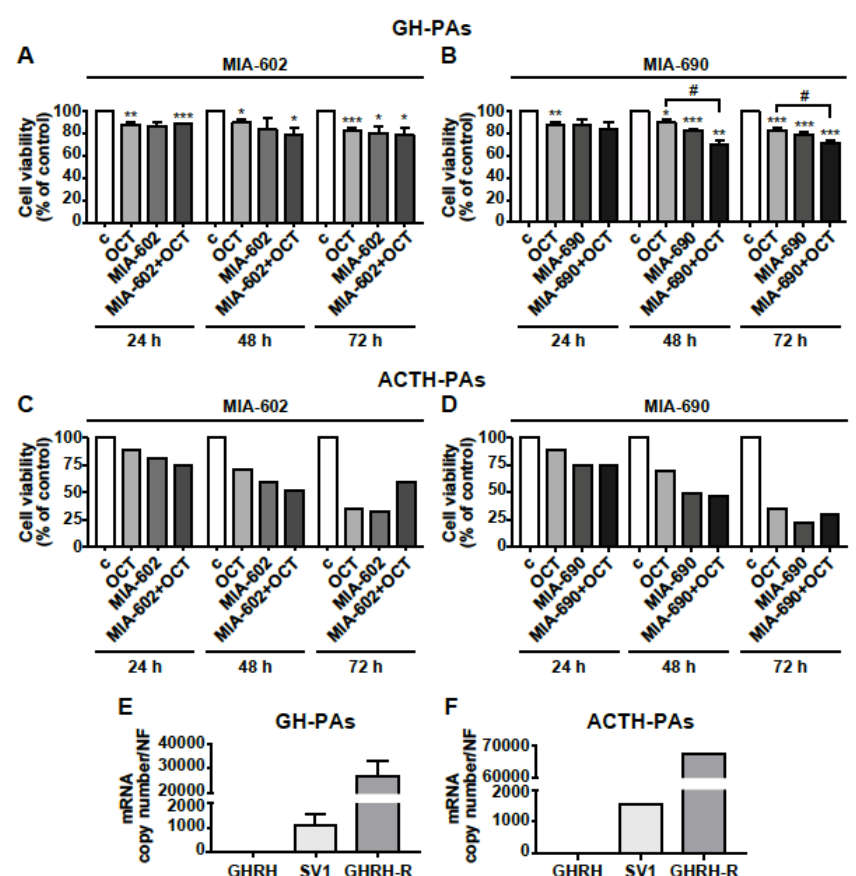
Figure 7. Effects of GHRH antagonists in human primary PA cell cultures. Cell viability, assessed by Alamar blue assay, in primary cells derived from GH-PAs ( A , B ) and ACTH-PAs ( C , D ). The cells were either untreated (c, control) or treated with 0.1 µm octreotide (OCT), 1 µm MIA-602 ( A ) or 1 µm MIA-690 ( B ), both alone or in combination with OCT, for the times indicated. Results, expressed as percent of control, are means ± SEM of three replicates. * p < 0.05, ** p < 0.01, *** p < 0.001 vs. c; # p < 0.05 by unpaired Stu dent’s t -test (n = 3 for A; n = 2 for B; n = 1 for C and D). For C and D, because of n = 1, no error bars are presented and no statistical analysis was performed. Expression profile of GHRH, SV1, and GHRH-R in GH-PAs ( E ) and ACTH-PAs ( F ) assessed by real-time PCR. Results represent absolute mRNA copy number adjusted by a normalization factor (NF), calculated from the expression levels of three control genes (GAPDH, ACTB, and HPRT) and are means ± SEM ( n = 3 for E; n = 1 for F).